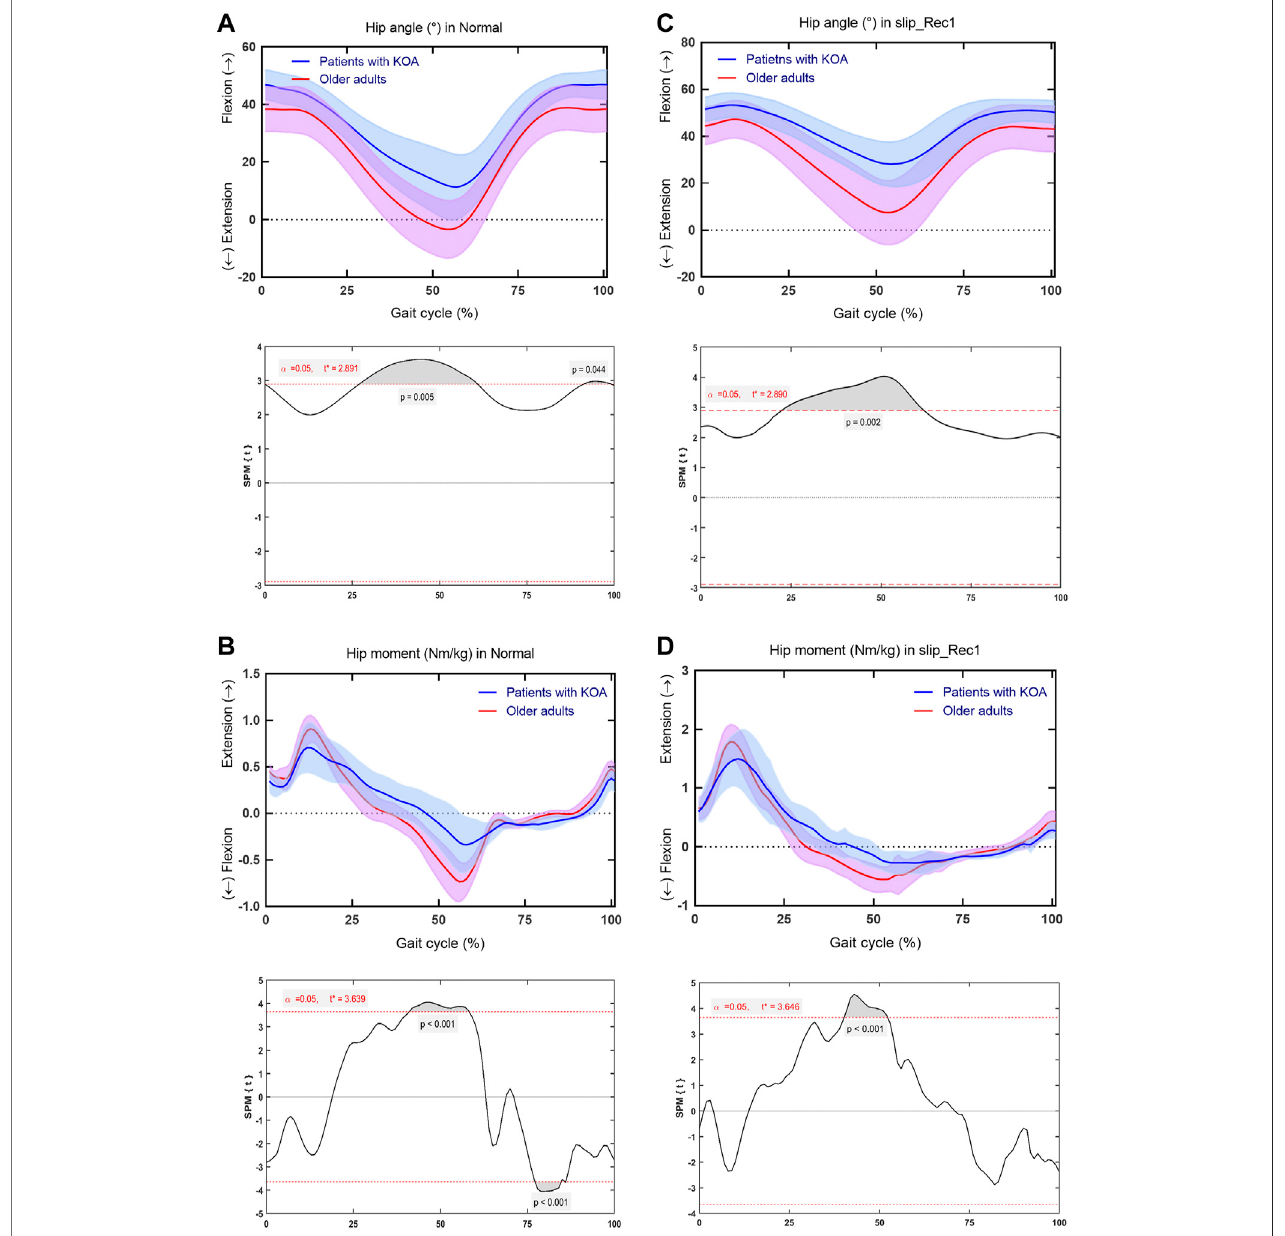
FIGURE7 | Comparison between patients withknee osteoarthritis(KOA) and older adults for the hip angle and hip moment inNormal and slip_Rec1 in the sagittal plane. Hip angle for patients with KOA and older adults in Normal (A) , hip moment for patients with KOA and older adults in Normal (B) , hip angle for patients with KOA andolderadultsinslip_Rec1 (C) ,andhipmomentforpatientswithKOAandolderadultsinslip_Rec1 (D) .Theupperandlowerpanelspresenttheaverageandstandard deviation of patients with KOA and older adults and the corresponding outcomes of the one-dimensional statistical parametric mapping (SPM) scalar trajectory t -test,respectively.Foreachanalysis,thesigni fi cancelevelissetat0.05,andthecorrespondingt*ispresentedasthehorizontalreddashedline.The p valuesassociated withthe supra-threshold clusters, denoted asthegrey shaded regions, arepresentedwhenever the test statistics continuumSPM{t} orSnPM{t}exceeds thethreshold.